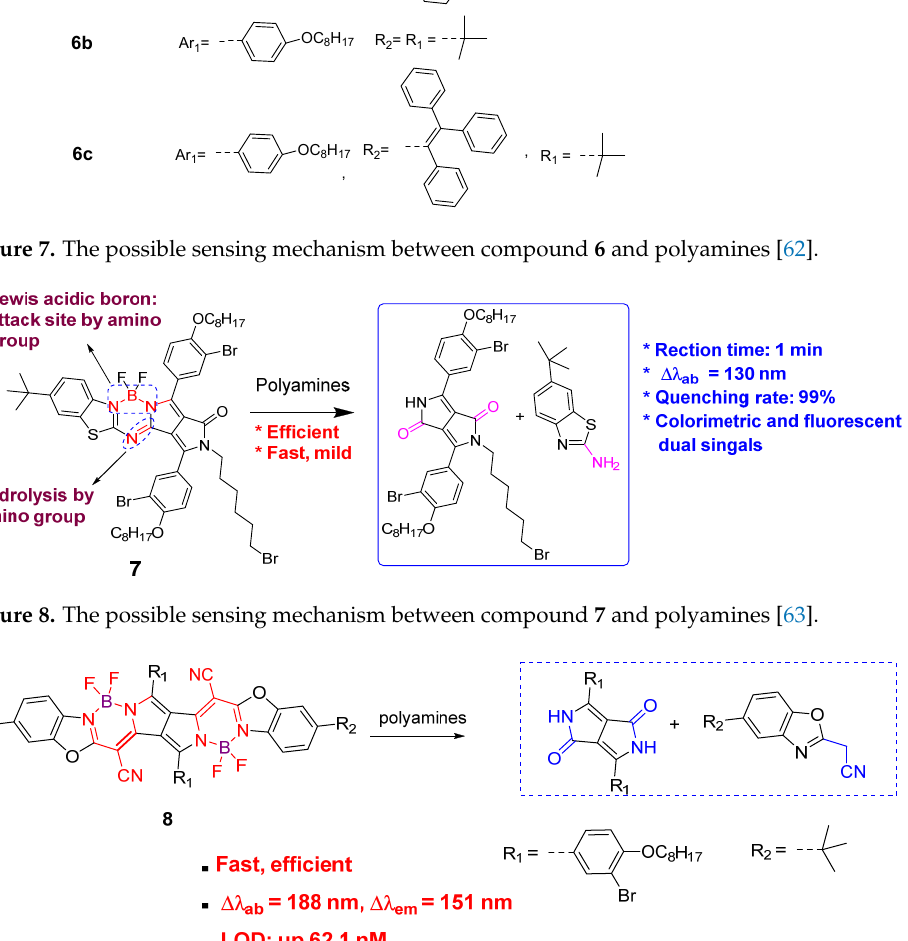
Figure 9. The possible sensing mechanism between compound 8 and the polyamines [64].